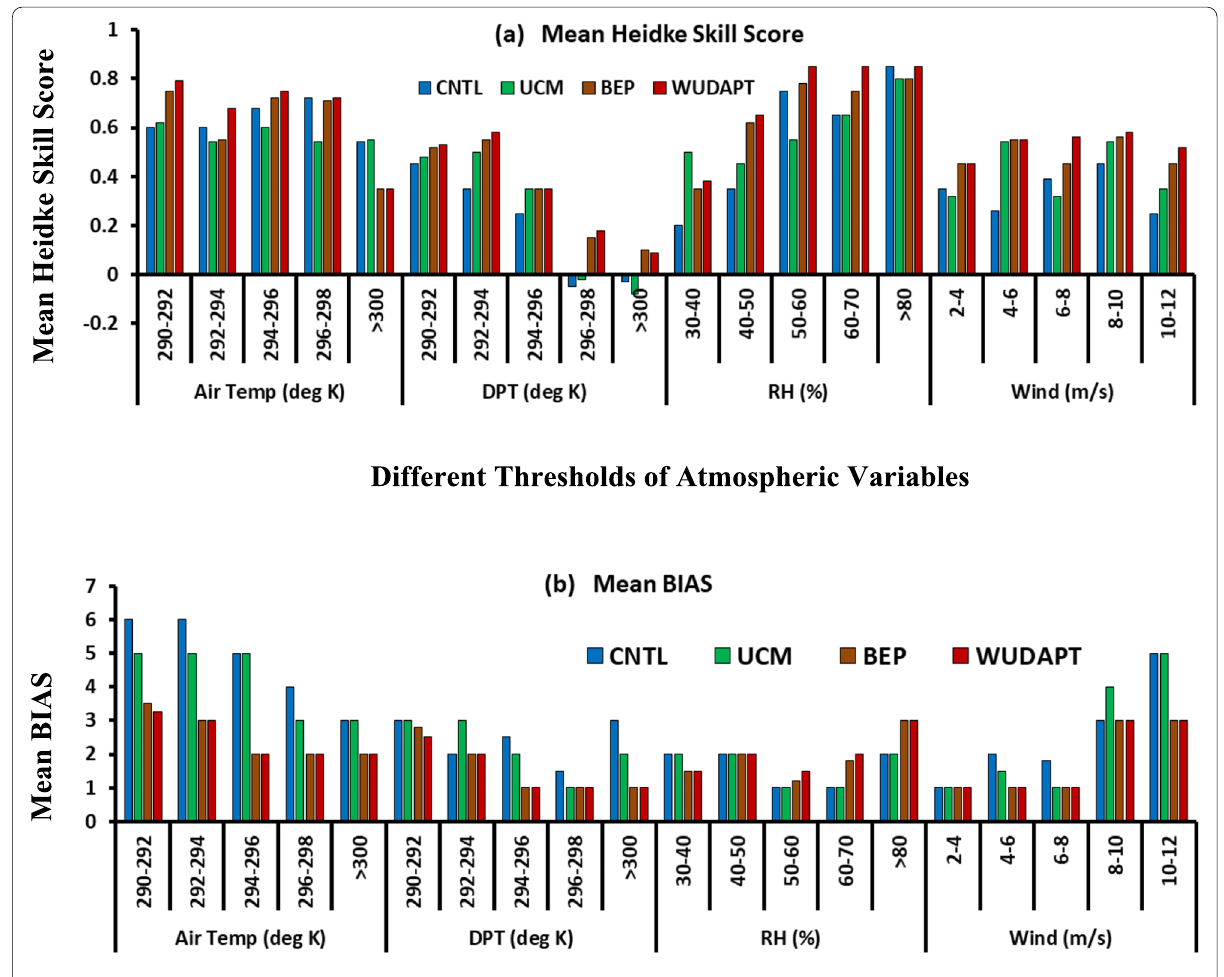
Fig. 4 Mean Heidke skill scores at different thresholds of ( a ) atmospheric variables in boundary layer (950–700 hPa) valid for 24 h forecast from all the thunderstorm cases for CNTL, UCM, BEP and WUDAPT experiments. b same as ( a ) but for mean